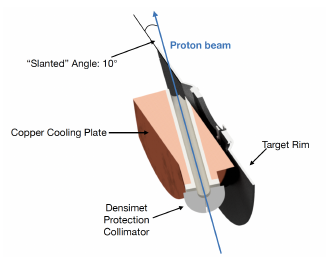
Figure 3. A section of the target TgH.